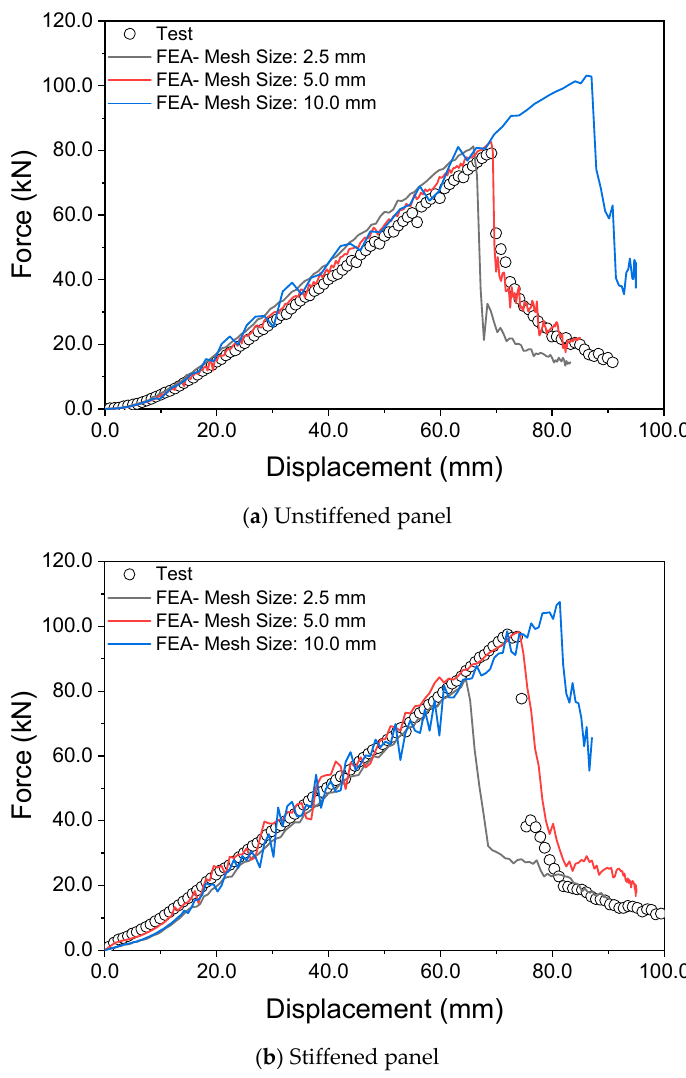
Figure 15. Comparison of numerical results with the test results. Table 3. Comparison of maximum force and displacement at fracture between experimental and numerical results.